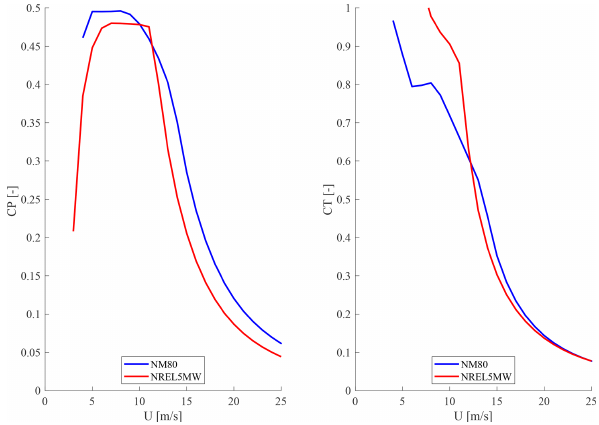
Figure 1. C P and C T curves for the NM80 and NREL 5MW tur-